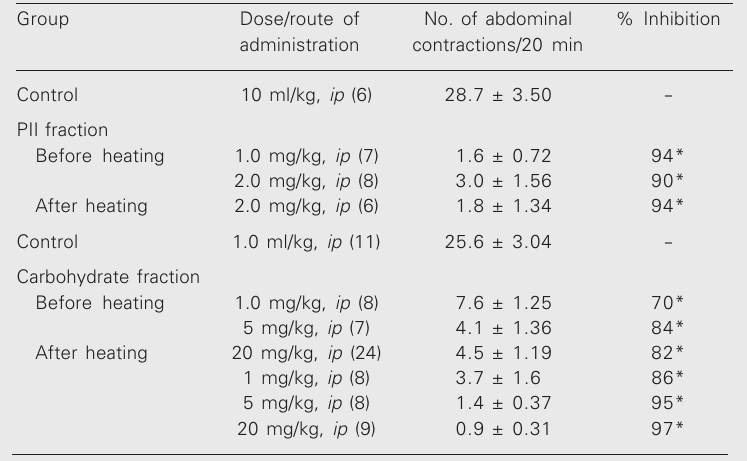
Table 4. Heating has no effect on the antinociceptive activities of the PII